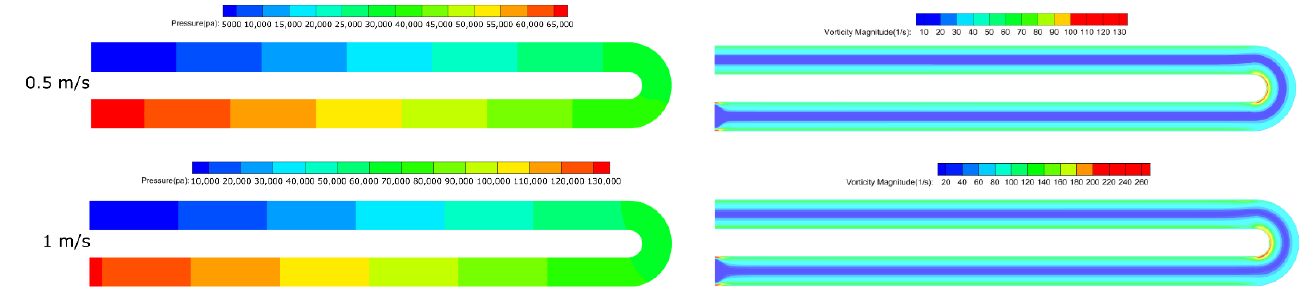
Figure 9. The pressure and the vorticity magnitude at the middle-height plane of the U-shaped channel. The pressure is displayed in the left column, and the vorticity magnitude is displayed in the right column. The upper row shows the data at the inlet velocity of 0.5 m/s at the temperature conditions of 283 K on the wall and 300 K of the incoming fluid at the inlet. The lower row shows the results at the inlet velocity of 1 m/s at the temperature conditions of 283 K on the wall and 300 K of the incoming fluid at the inlet.